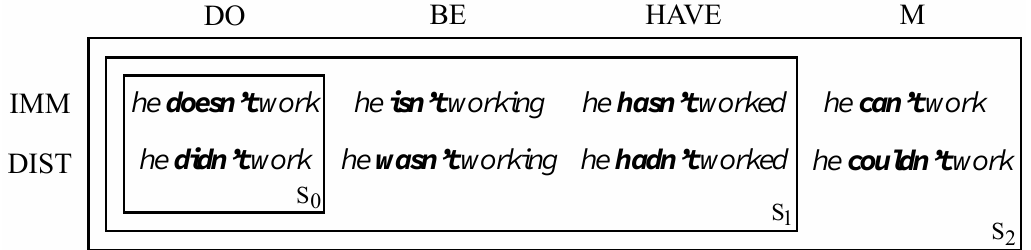
Figure 5. The finite verb elaborated by negation.